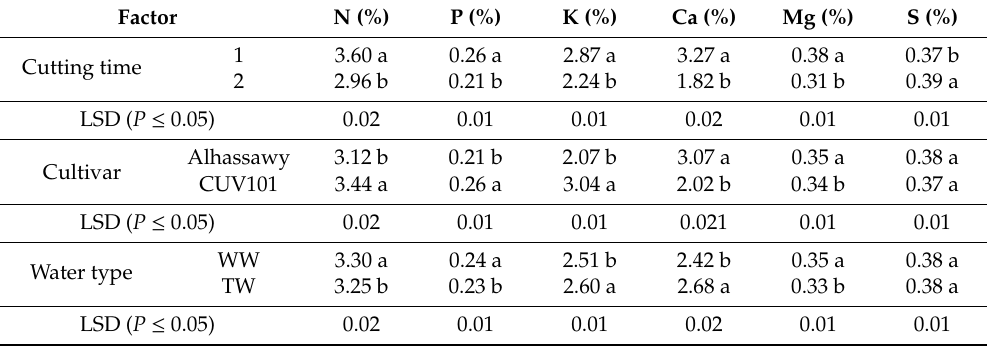
Table3. Effectsofcuttingtime,cultivar,andwatertypeusedforirrigationonalfalfamacronutrientcontents.